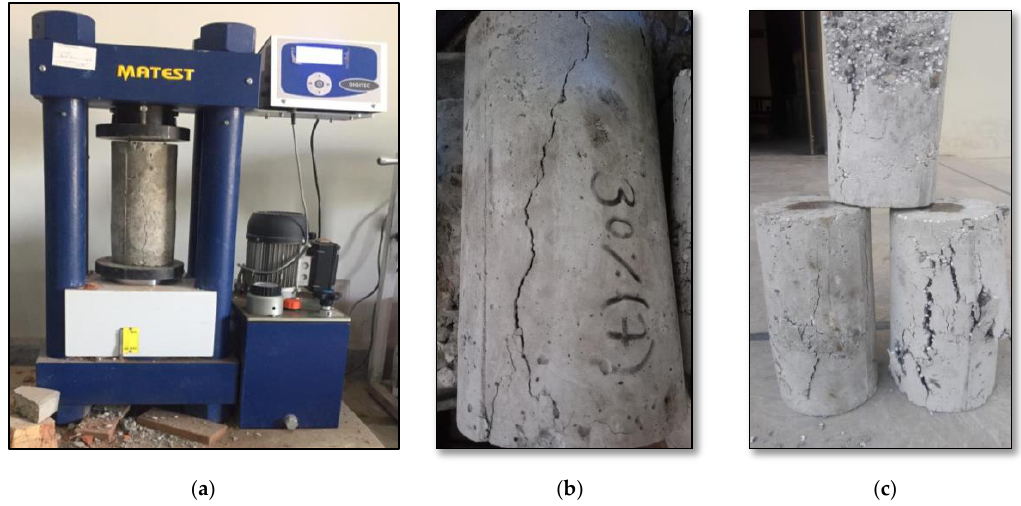
Figure 6. ( a ) Compressive strength test machine; ( b ) Cracked cylinder; ( c ) Interface of cracked cylinder.